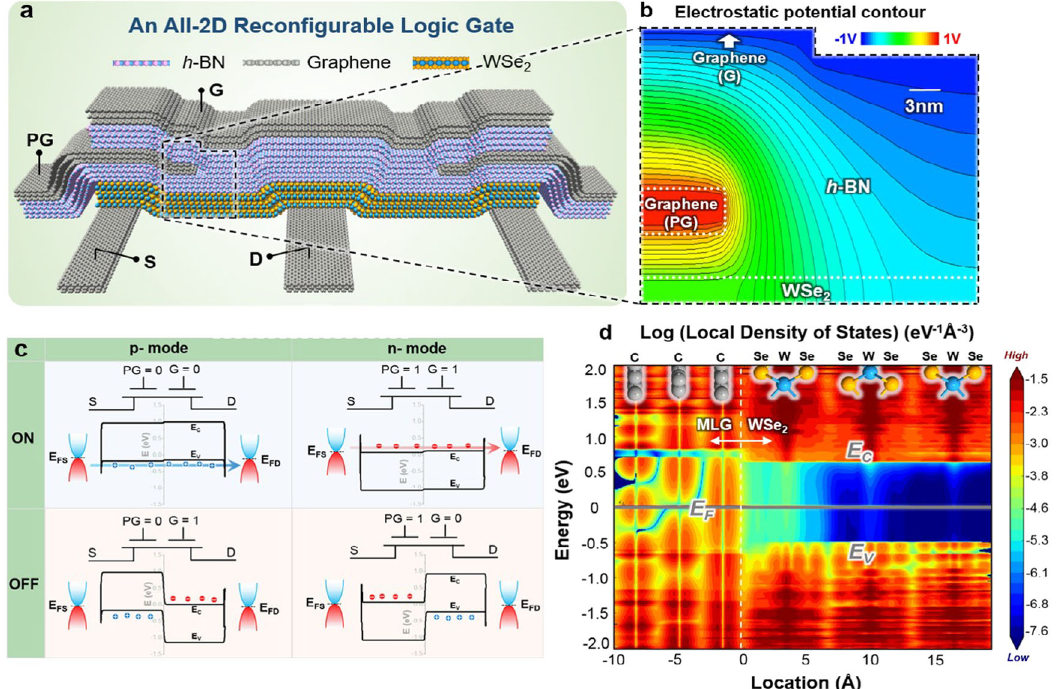
Fig. 1 Operation mechanism and design of the quantum engineered all-2D recon fi gurable logic gate. a The all-2D recon fi gurable logic gate designed and demonstrated in this work. S, D, and G represent Source, Drain, and Gate terminals, respectively. PG represents programming gate. b Simulated electrostatic potential distribution contour in the essential area of the individual 2D vdW Rec-FET. PG effectively screens the electrostatic in fl uence of G over the channel under PG. c Circuit symbols/representations and simulated band diagrams of demonstrated 2D vdW Rec-FETs in ON and OFF states and in n - and p -type con fi gurations, showing their operation mechanisms. E C/V represents conduction/valence band edge of WSe 2 channel. E FS / E FD represents Fermi level in the multilayer graphene (MLG) source/drain contact. Logic levels of “ 0 ” and “ 1 ” correspond to PG/G voltages of − 8 and 8 V in the simulation, respectively. The red/blue circles represent electron/hole, respectively. d DFT simulation of the local density of states veri fi es the mid-gap band alignment between multilayer grapheme and WSe 2 . Only the inner three layers are shown in the fi gure. The physical contact interface is marked with a white vertical dash line. E F represents Fermi